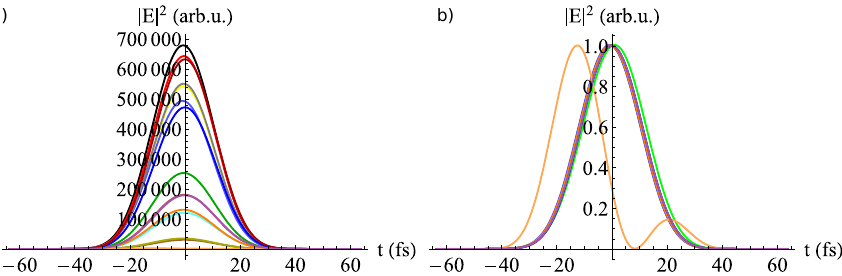
2 ( t ) ) of the laser field after being reflected by the helical mirror and Figure 3. The temporal profile ( E | | focused with an f = 1500 mm mirror. The colors correspond to the positions where the fluence profile is marked in Figure 2d: ( a ) non-normalized and ( b ) normalized. The light orange plot corresponds to x = y = 0, where the signal is only an irrelevant, small amount of noise. Normalization was performed so that the maximum of each plot reached 1. The maximum value of the light orange plot appeared close to t = 20 fs, whereas at t = 0 the signal dropped. −